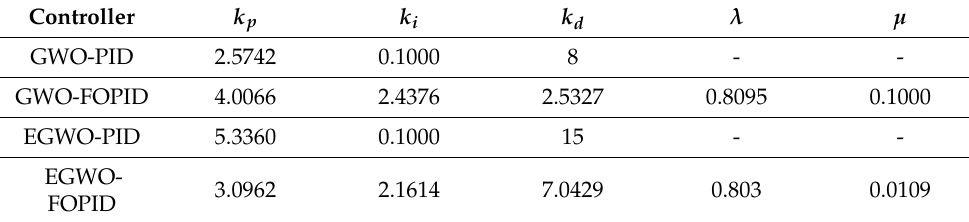
Table 3. FOPID and PID obtained